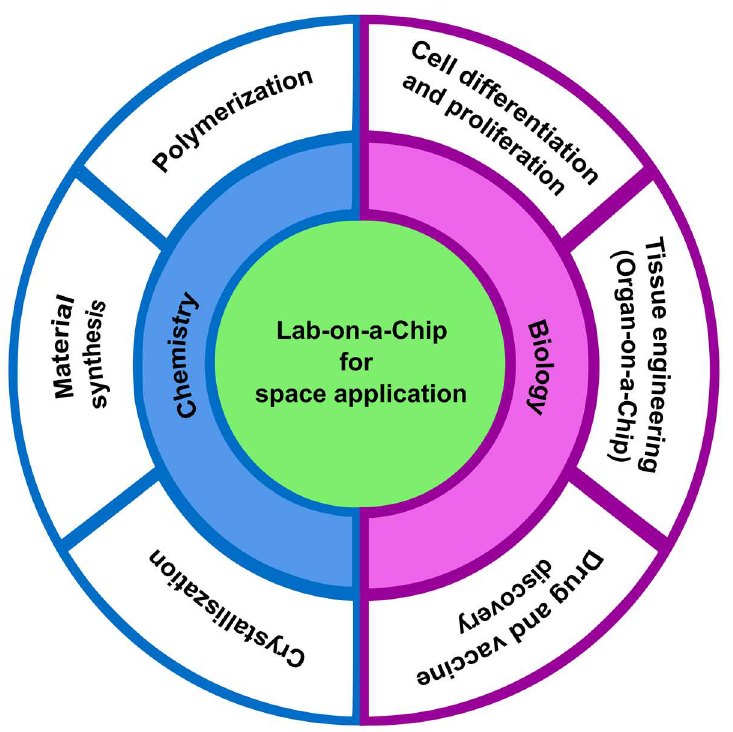
Figure 1. Lab-on-a-chip for biological and chemical space applications.